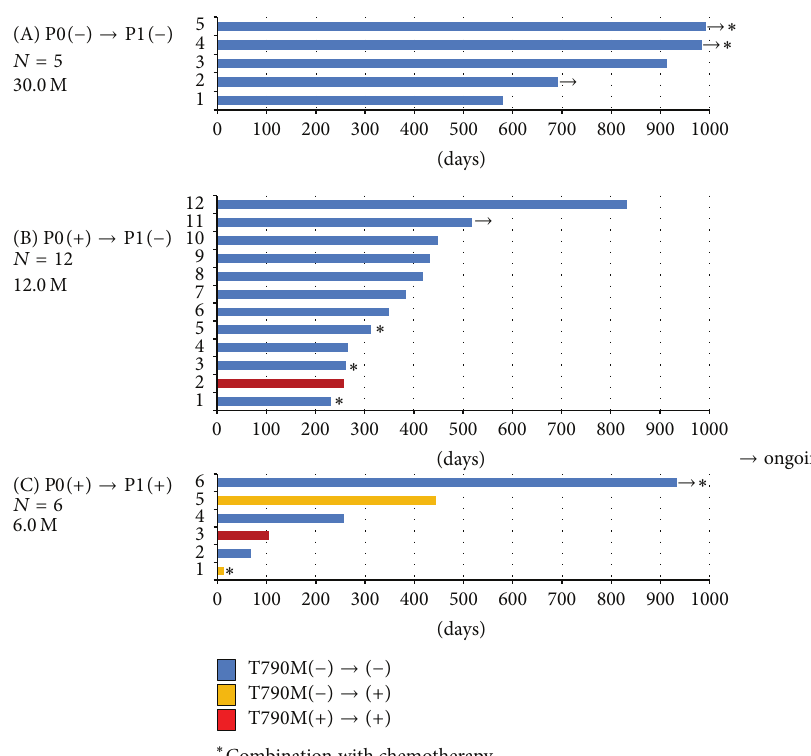
Figure 1: Relation between plasma EGFR mutations and duration of EGFR-TKIs treatment. (A): group of cases having no EGFR mutation in the plasma before TKI treatment (P0) and during TKI treatment (P1). (B): group of patients whose EGFR mutation status converted from positive at P0 to negative at P1. (C): group of patients with mutations both at P0 and at P1. Arrows indicate cases that are still under treatment. Asterisks show cases receiving combination of TKIs and chemotherapy.